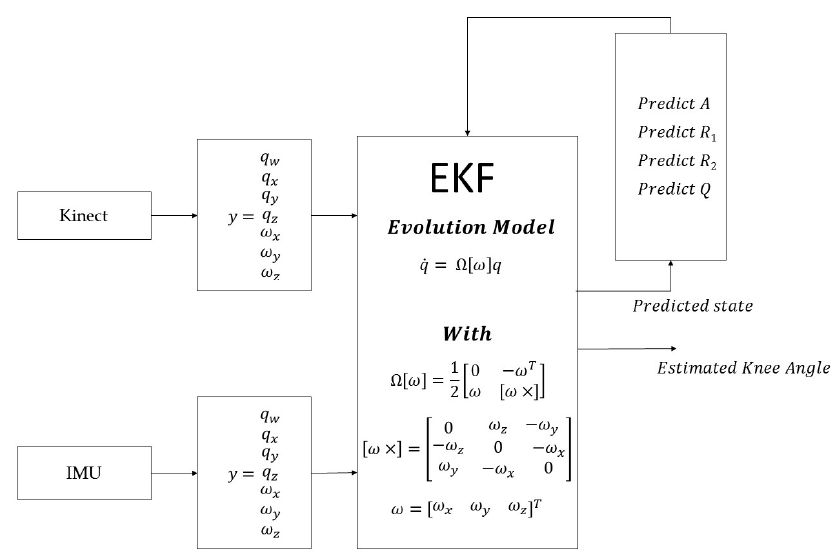
Figure 5. Quaternion based extended Kalman observer scheme for fusion.